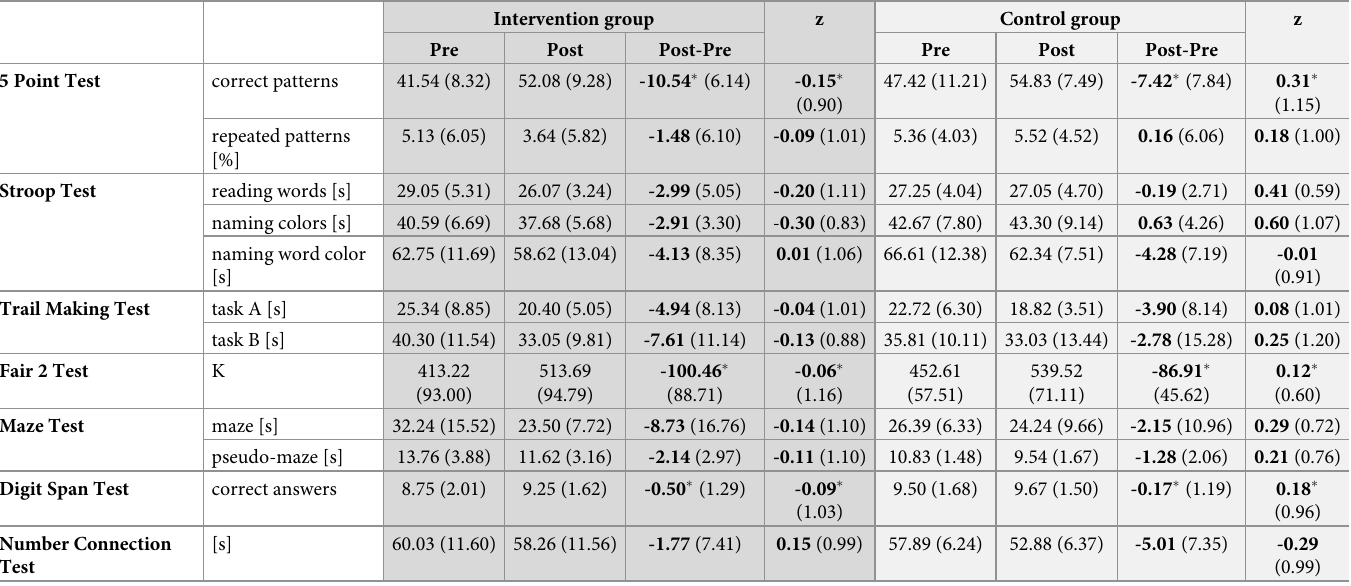
Table 1. Cognitive performance.